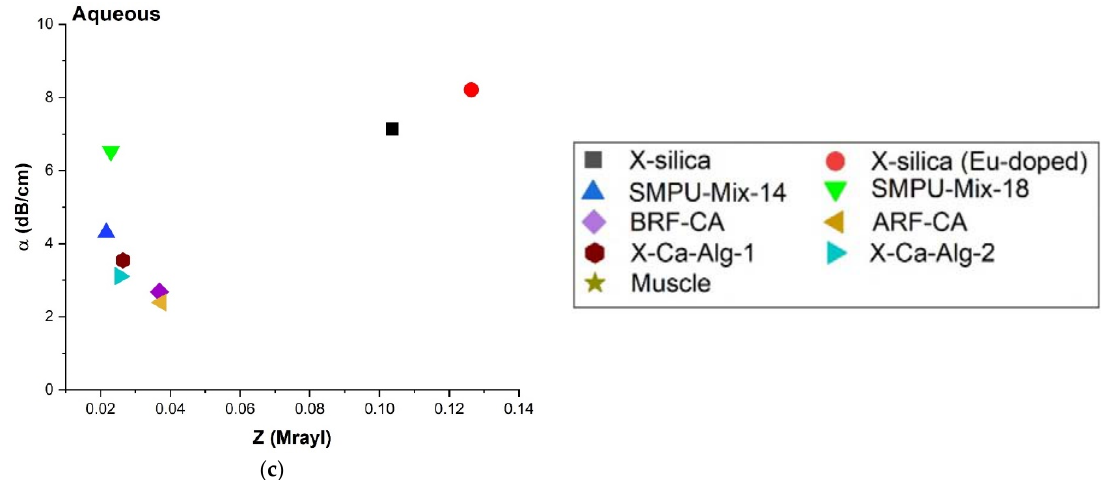
Figure 9. Comparison of attenuation coefficient ( α ) at 8.5 MHz and acoustic impedance (Z) for all three configurations; ( a ) SC, ( b ) SM, and ( c ) Aq environment.